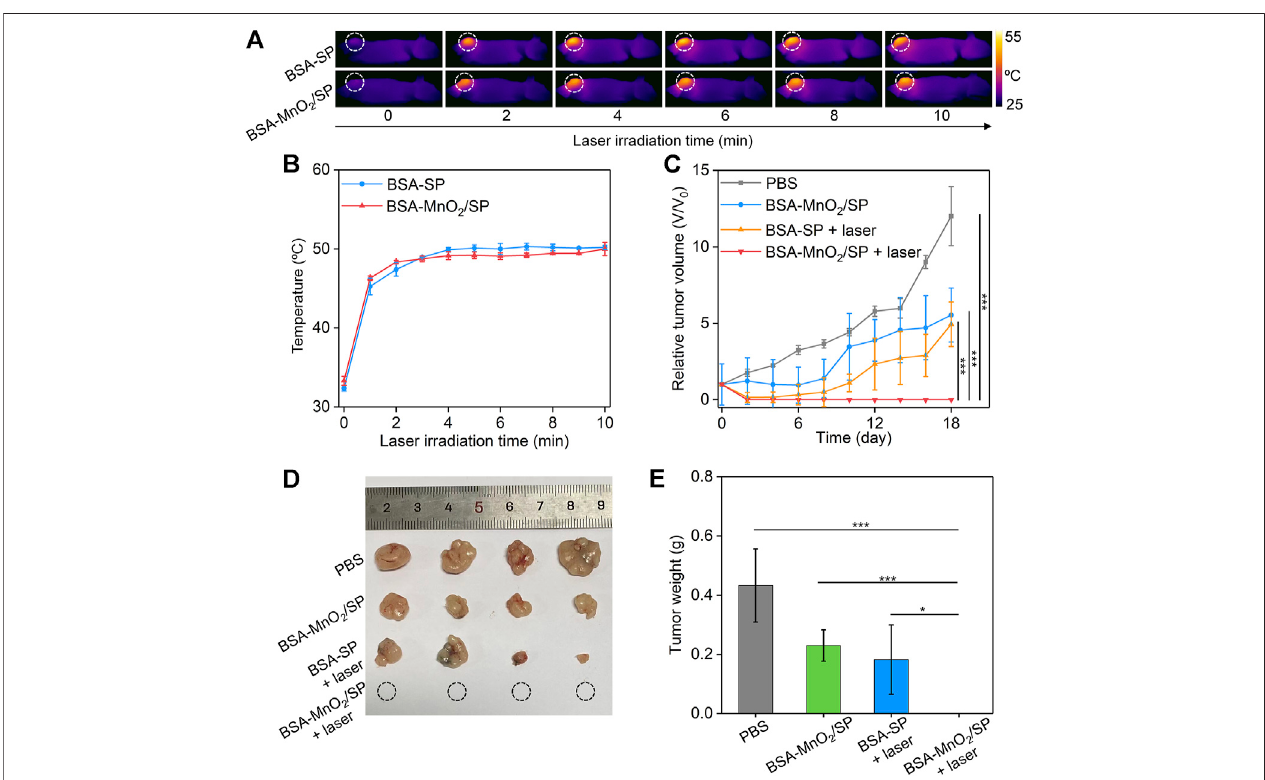
FIGURE 6 | Evaluation of in vivo antitumor ef fi cacy. (A) Thermal imaging of HepG2 tumor – bearing nude mice after treatment with BSA/SP nanoparticles or BSA- MnO 2 /SP nanocomposites under 808 nm laser irradiation (1.0 W/cm 2 ) for different times. (B) Temperature changes in tumor sites for BSA/SP nanoparticle – or BSA- MnO 2 /SP nanocomposite – injected mice at different laser irradiating times. (C) Relative tumor volumes of HepG2 tumor – bearing mice after different treatments. (D) Photographs of tumors from HepG2 tumor – bearing mice after different treatments for 18 days. (E) Tumor weight of HepG2 tumor – bearing mice after different treatments for 18